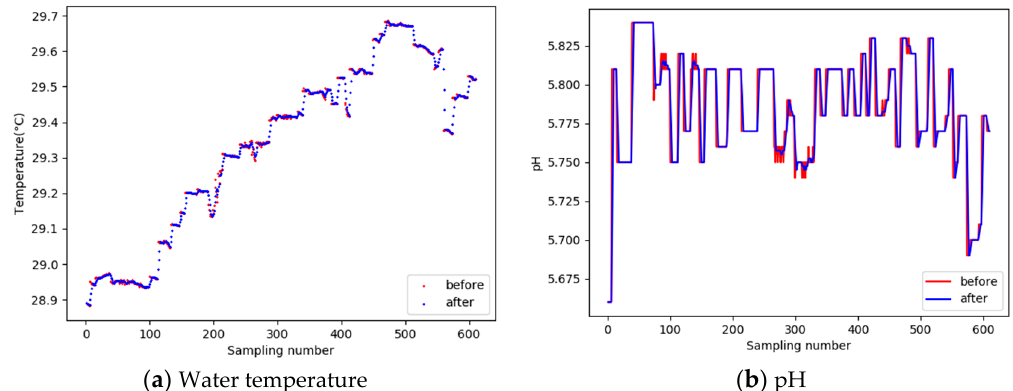
Figure 11. Comparison of water quality data before and after noise reduction.